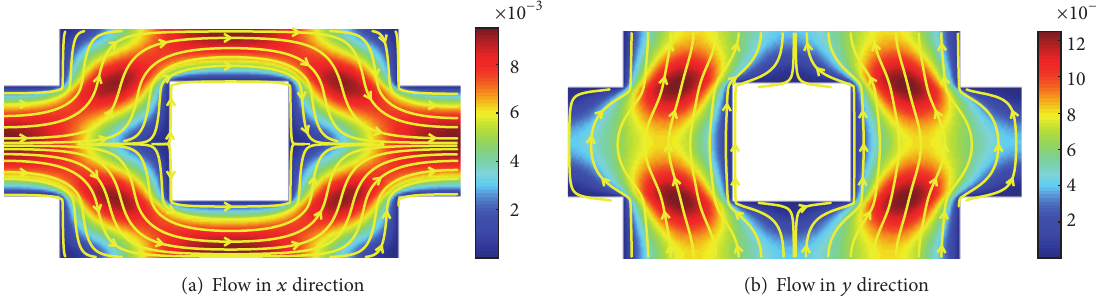
Figure 11: Fluid flow through a staggered-array of squares, 𝜙 = 0.73 . Fluid speed (i.e., magnitude of velocities) is indicated by color, and direction is indicated by flow lines. Fluid speed is nondimensional.